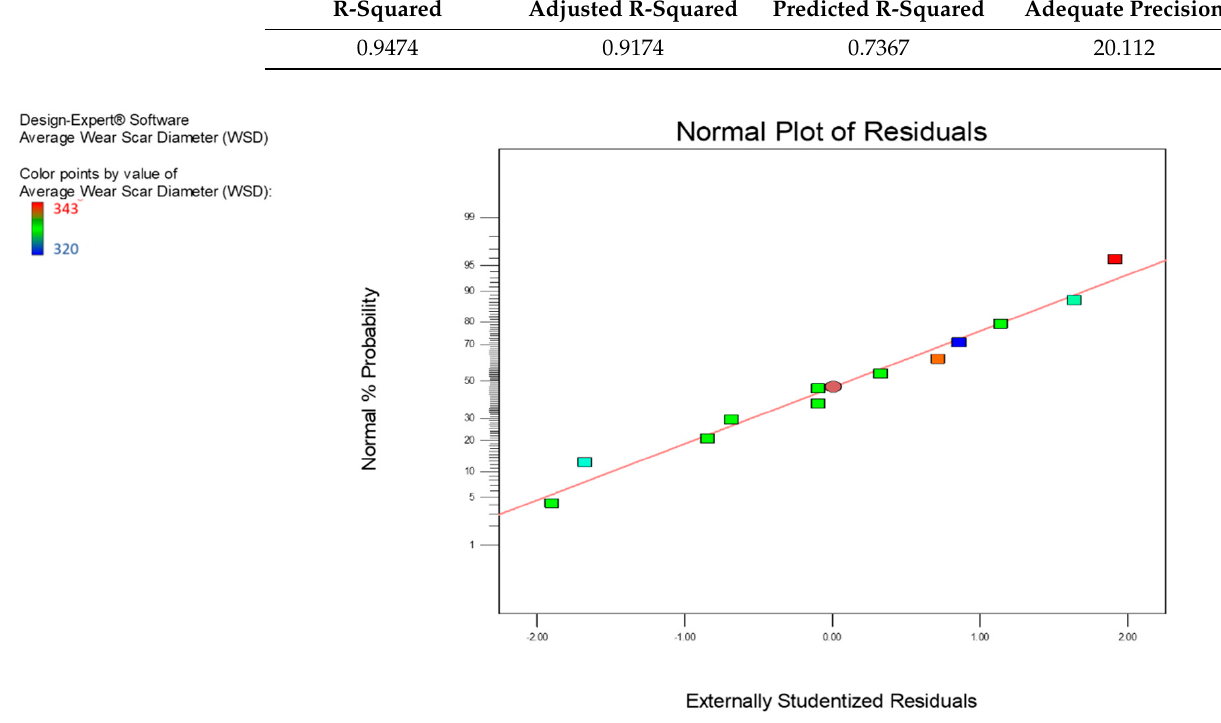
Table 7. The model summary of the quadratic model for the average WSD. R-Squared Adjusted R-Squared Predicted R-Squared